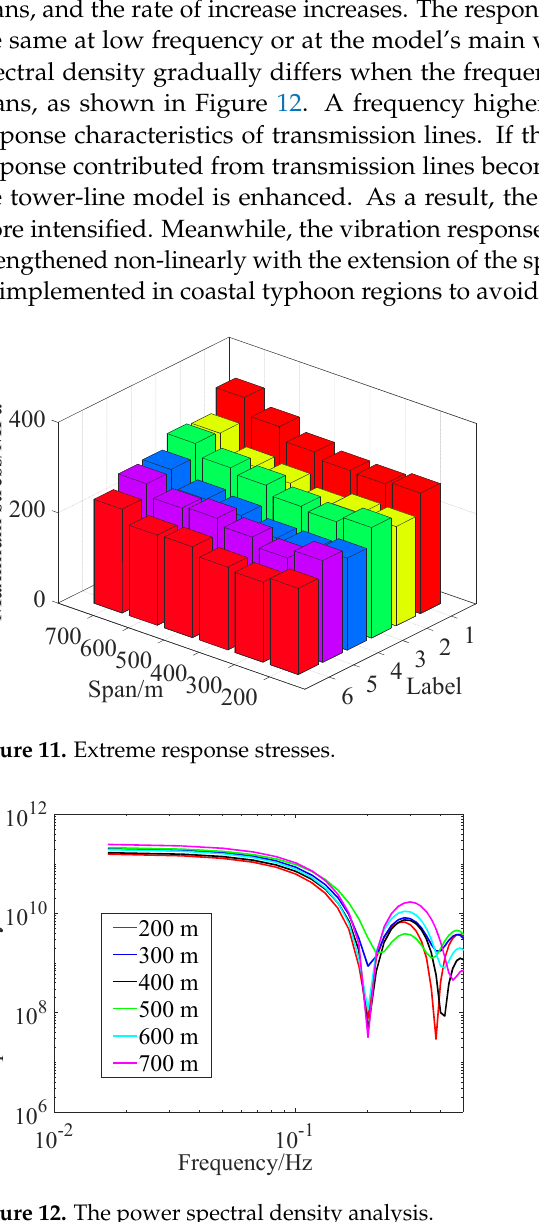
Figure 10. The instantaneous maximum stress: ( a ) Scatter plot; ( b ) Continuous plot.